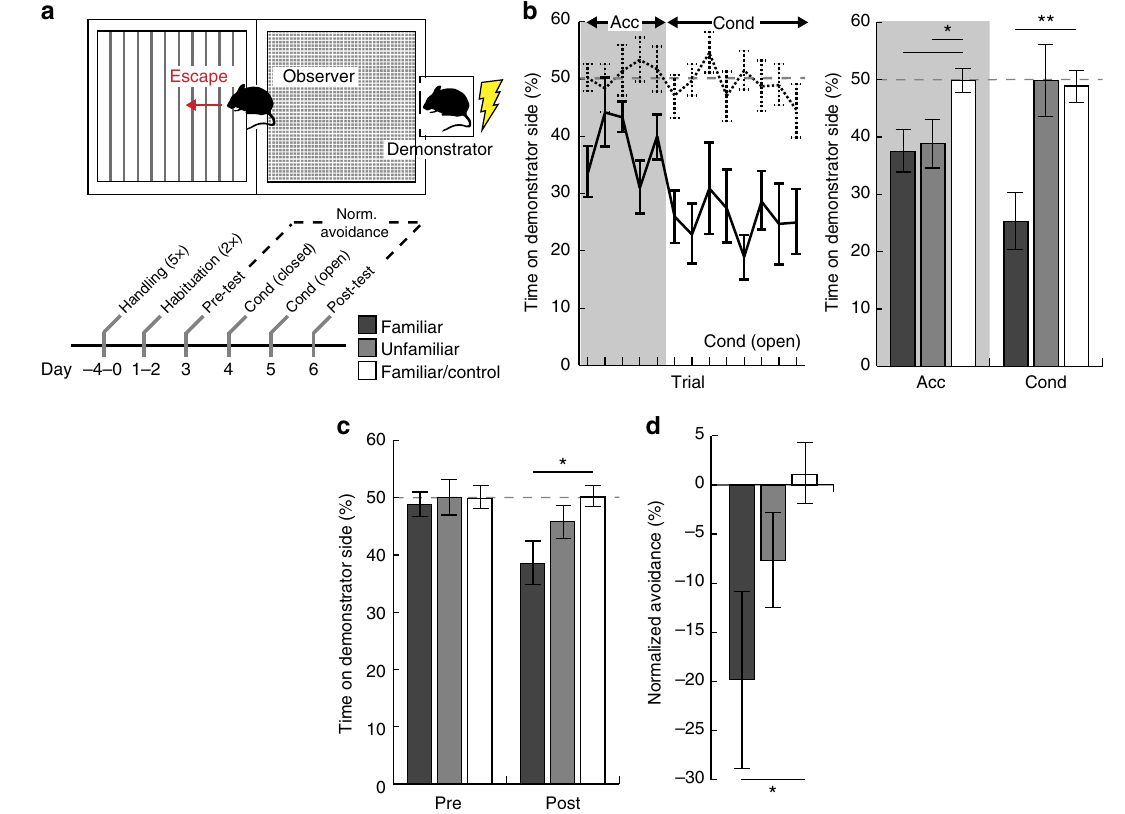
Fig. 2 Familiar male mice exhibit escape behavior in a novel socially induced avoidance paradigm. a Schematic of the socially induced avoidance